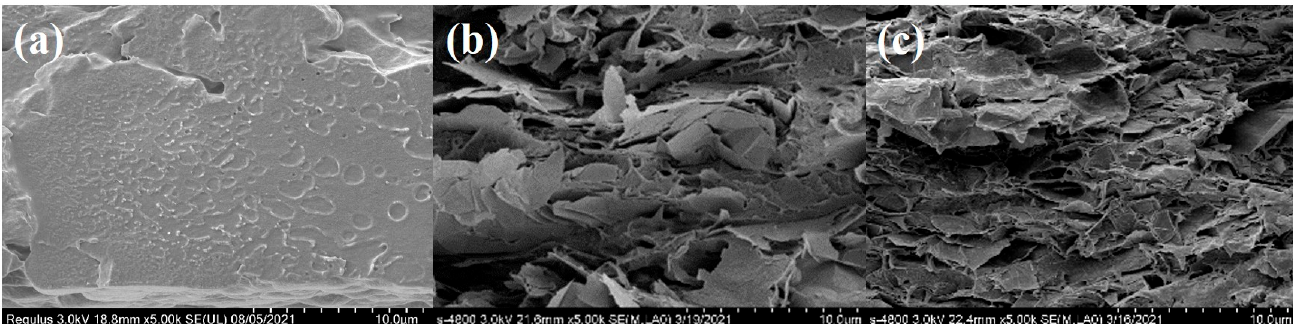
Figure 7. SEM images of GNS/PVDF and GNS@P3HT/PVDF membranes: ( a ) PVDF; ( b ) 20 wt% GNS/PVDF; ( c ) 20 wt% GNS@P3HT (6000)/PVDF.